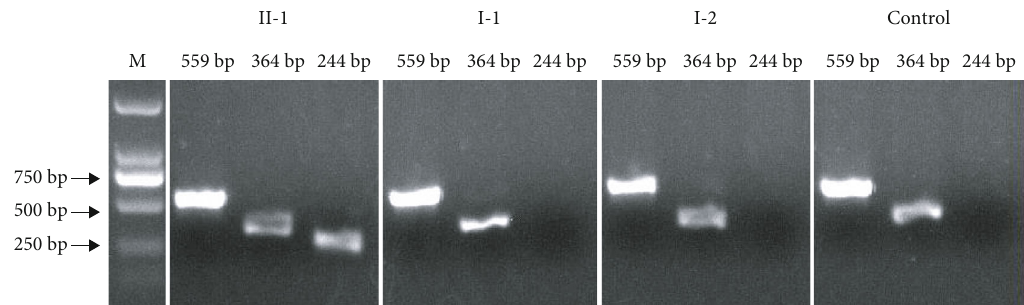
Figure 4: Electrophoresis gel fi gure of 244bp, 364bp, and 559bp PCR product in patient II-1, una ff ected parents I-1/I-2, and control. M: